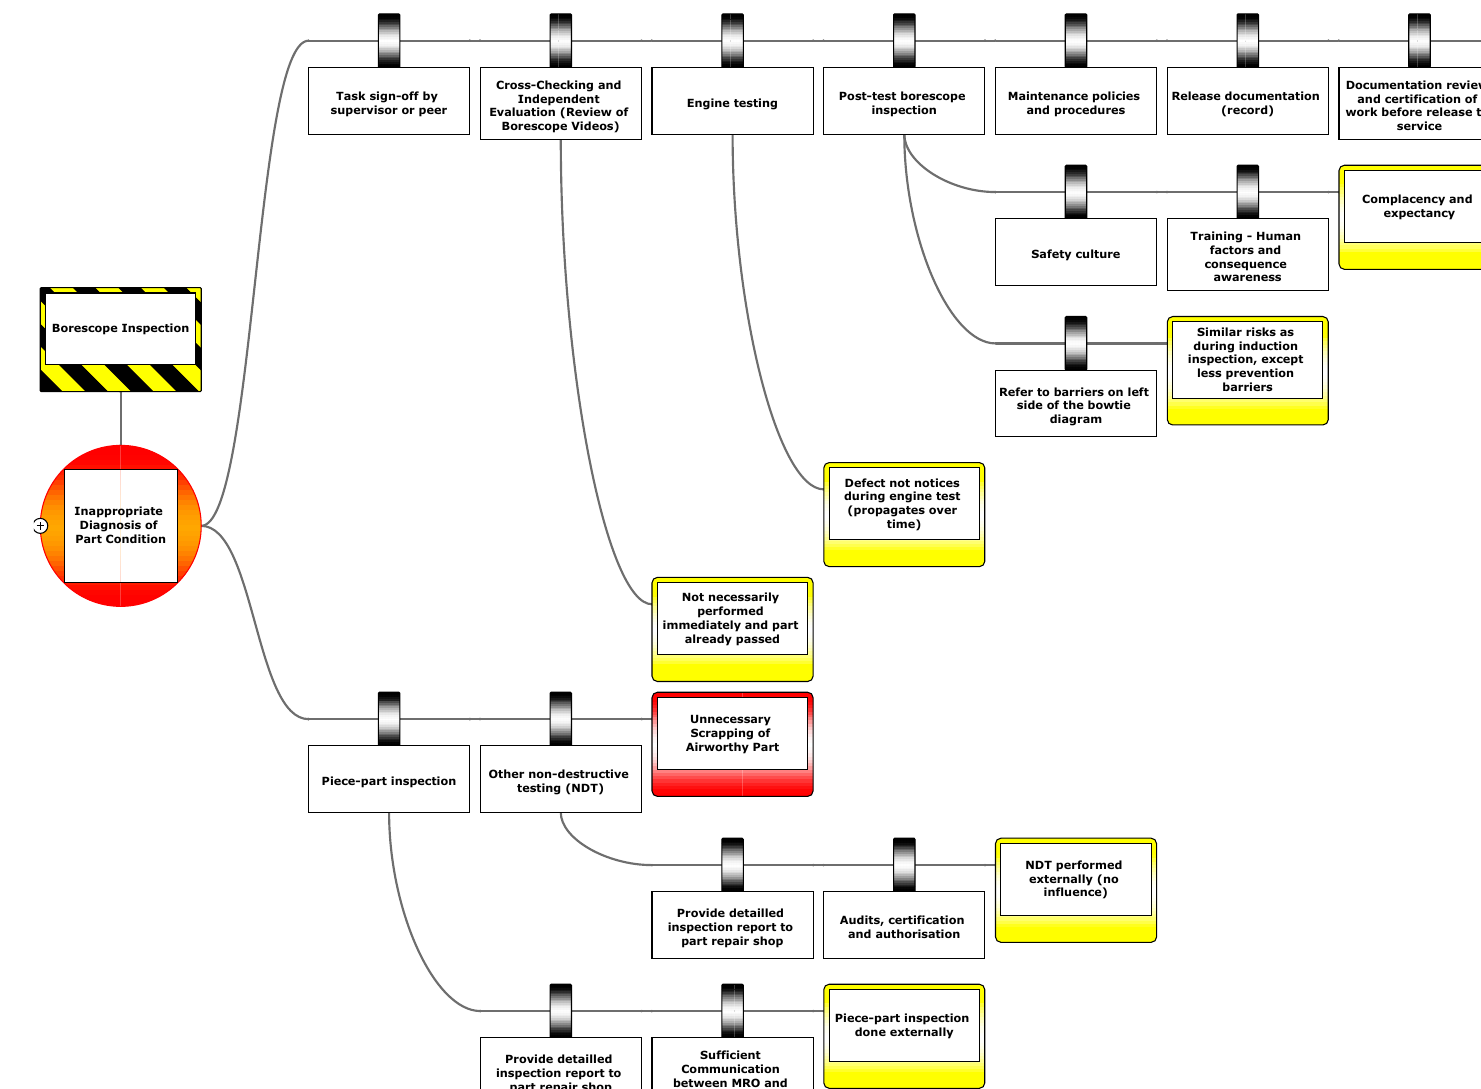
Figure A4. Consequence side of the Bowtie diagram with recovery barriers, escalation factors, and escalation factor barriers.